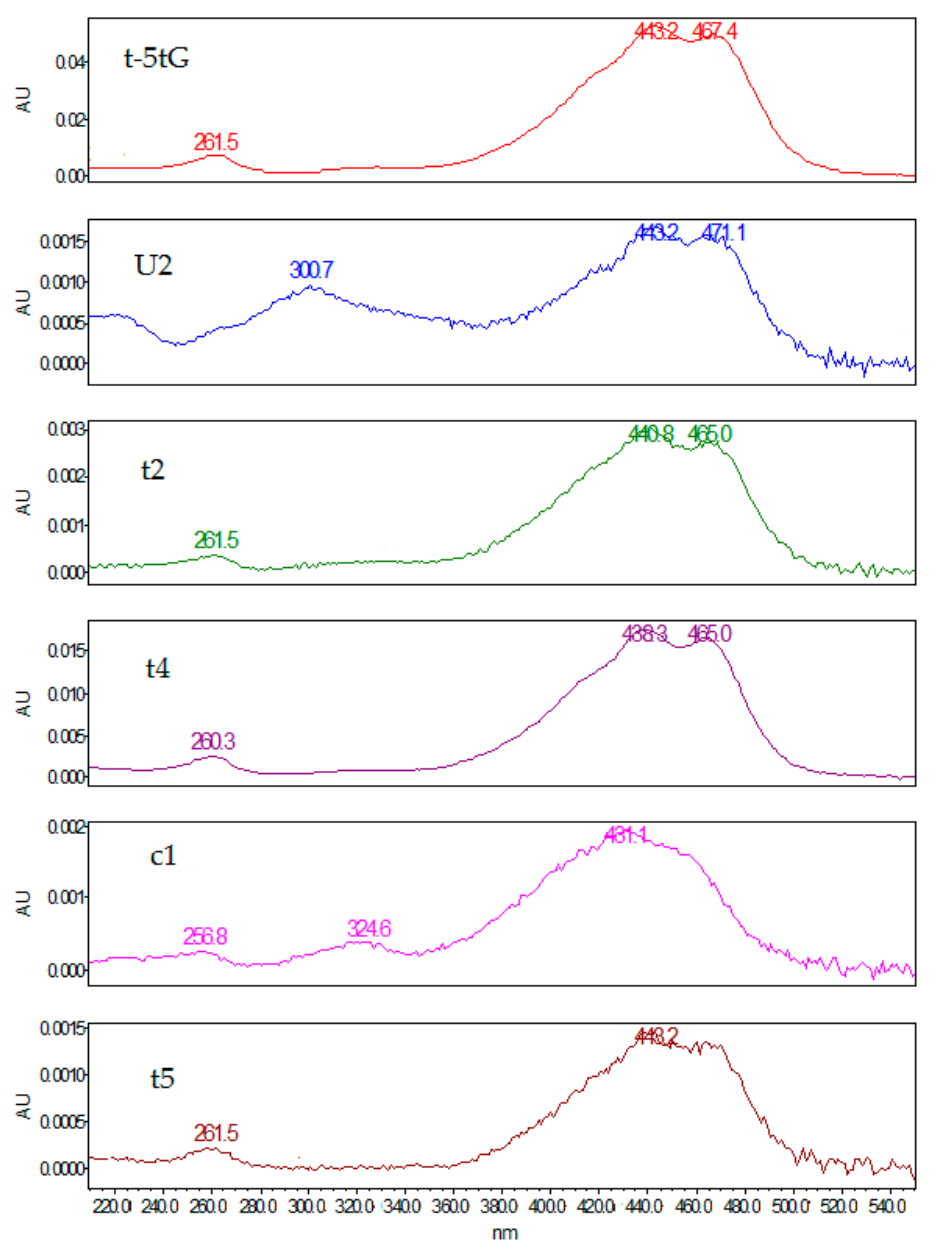
Figure A1. Ultraviolet-vis spectra of some compounds detected with the Kinetex C18 column (chromatogram A displayed in Figure 1).